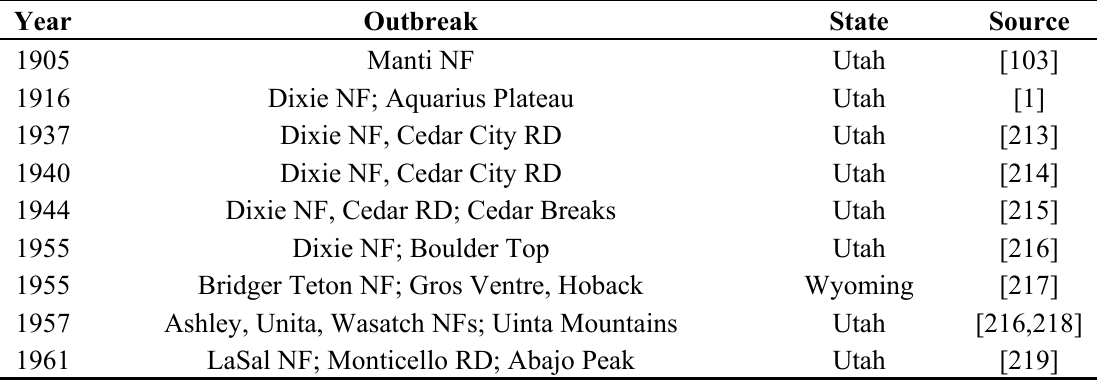
Table A1. A chronology of historic spruce beetle outbreaks in Utah and Wyoming, from 1905–2013 (NF is National Forest; RD is Ranger